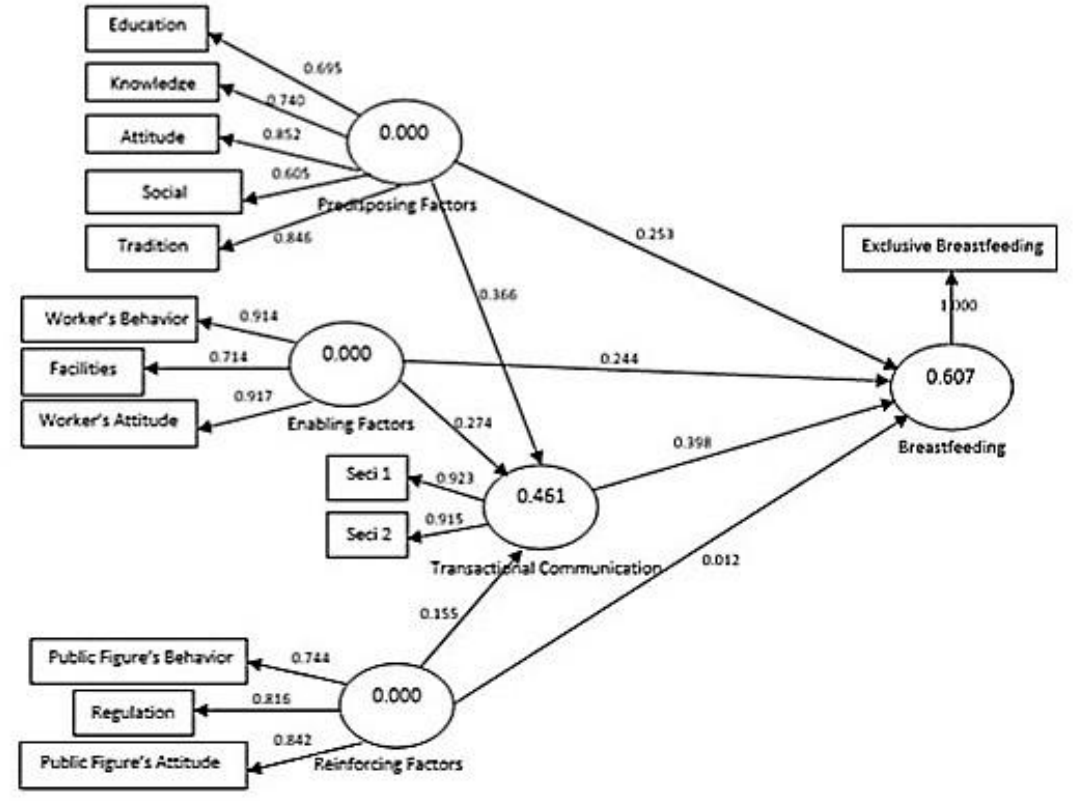
Figure 2. Result of Outer Model with Loading Factor Value using Partial Least Square